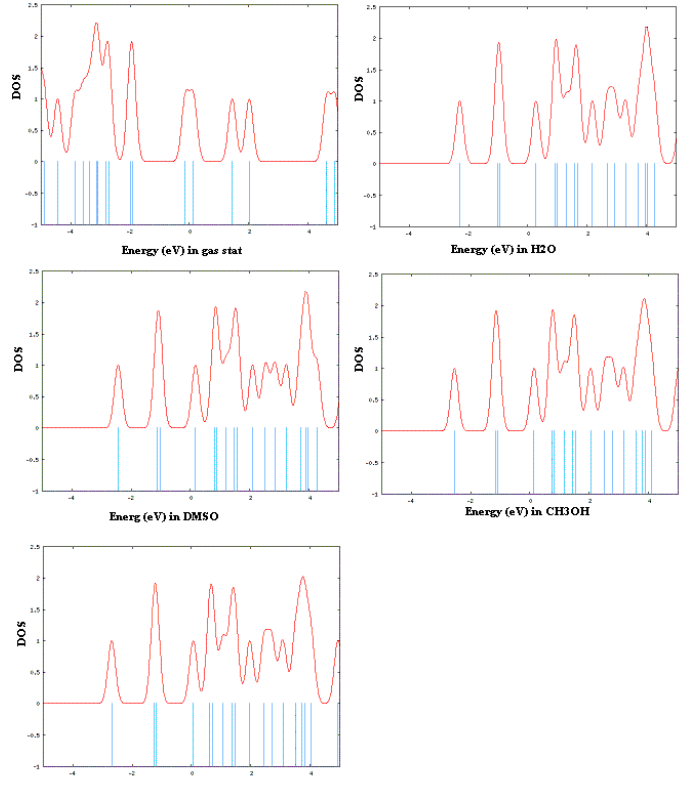
Figure 3. Electronic density of states for V isomer at the BLYP/6-311G** level in different